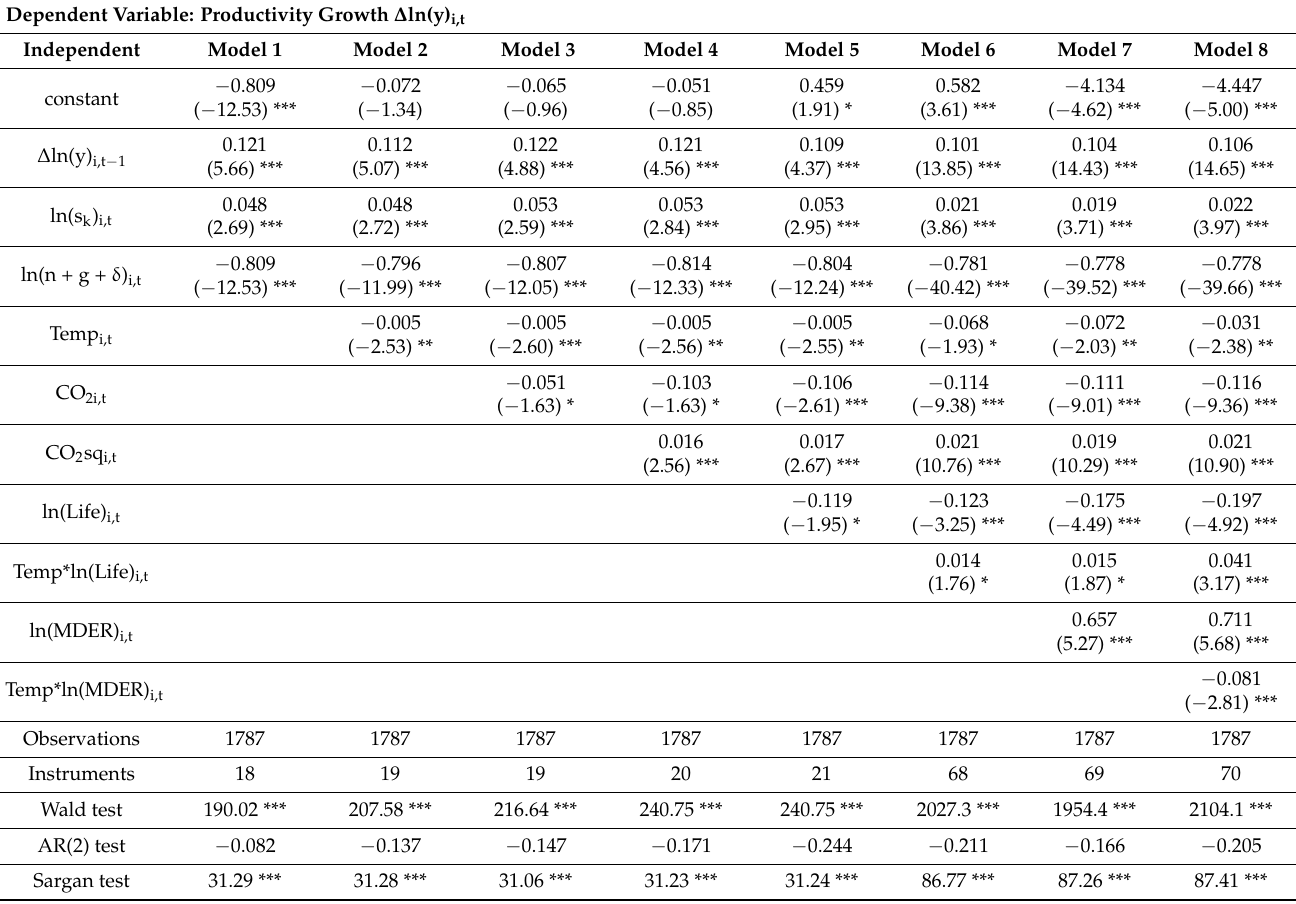
Table 2. Dynamic panel regression results of Equation